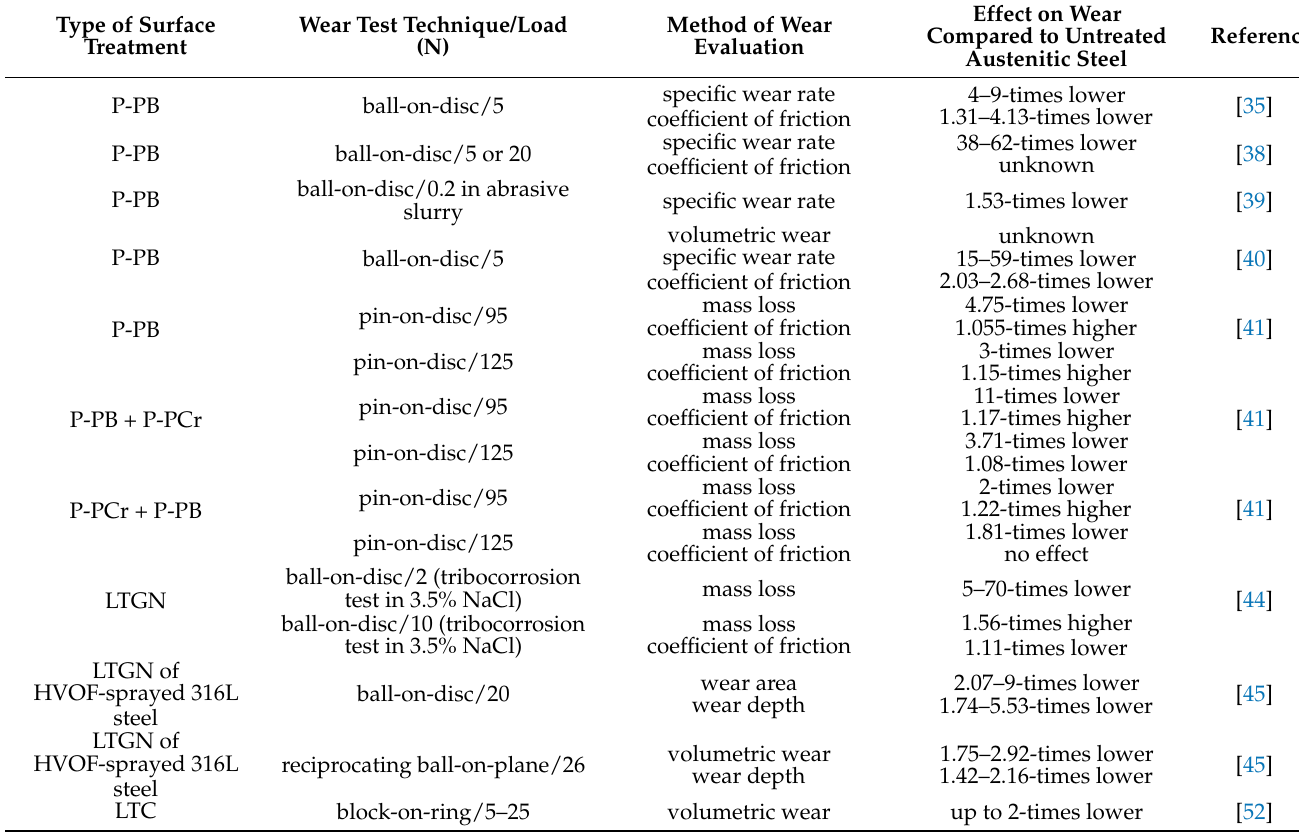
Table 4. Effect on wear in comparison with untreated austenitic steel using the various methods of wear tests and wear evaluations after the surface treatment by various thermochemical techniques. Effect on Wear Type of Surface Wear Test Technique/Load Method of Wear Compared to Treatment (N) Evaluation